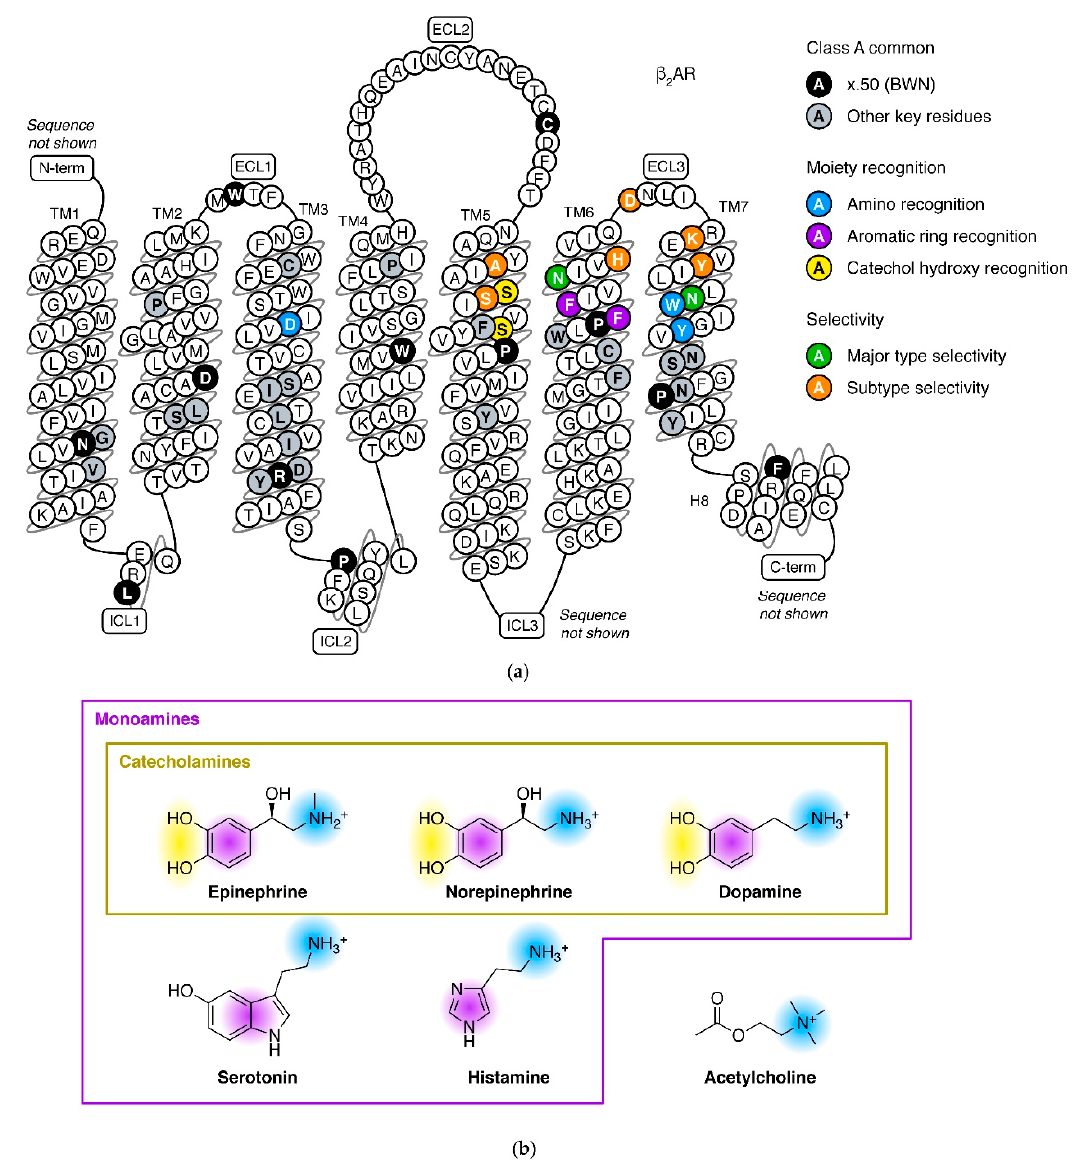
Figure 2. Mechanisms of ligand recognition by adrenergic receptors. ( a ) Key residues for protein structure maintaining, receptor activation, and endogenous ligand recognition, marked with color on snake plot of β 2 AR. x.50 are Ballesteros– Weinstein numbering (BWN) [22] of the most conserved residues in each segment. Sequence of N-terminus, ICL3, and C-terminus are not shown because these regions do not contain key residues and are very long. ( b ) Chemical structures of monoamine neurotransmitters (shown in protonated state) and acetylcholine. Moieties colored in consistent with interacting residues in panel ( a ).